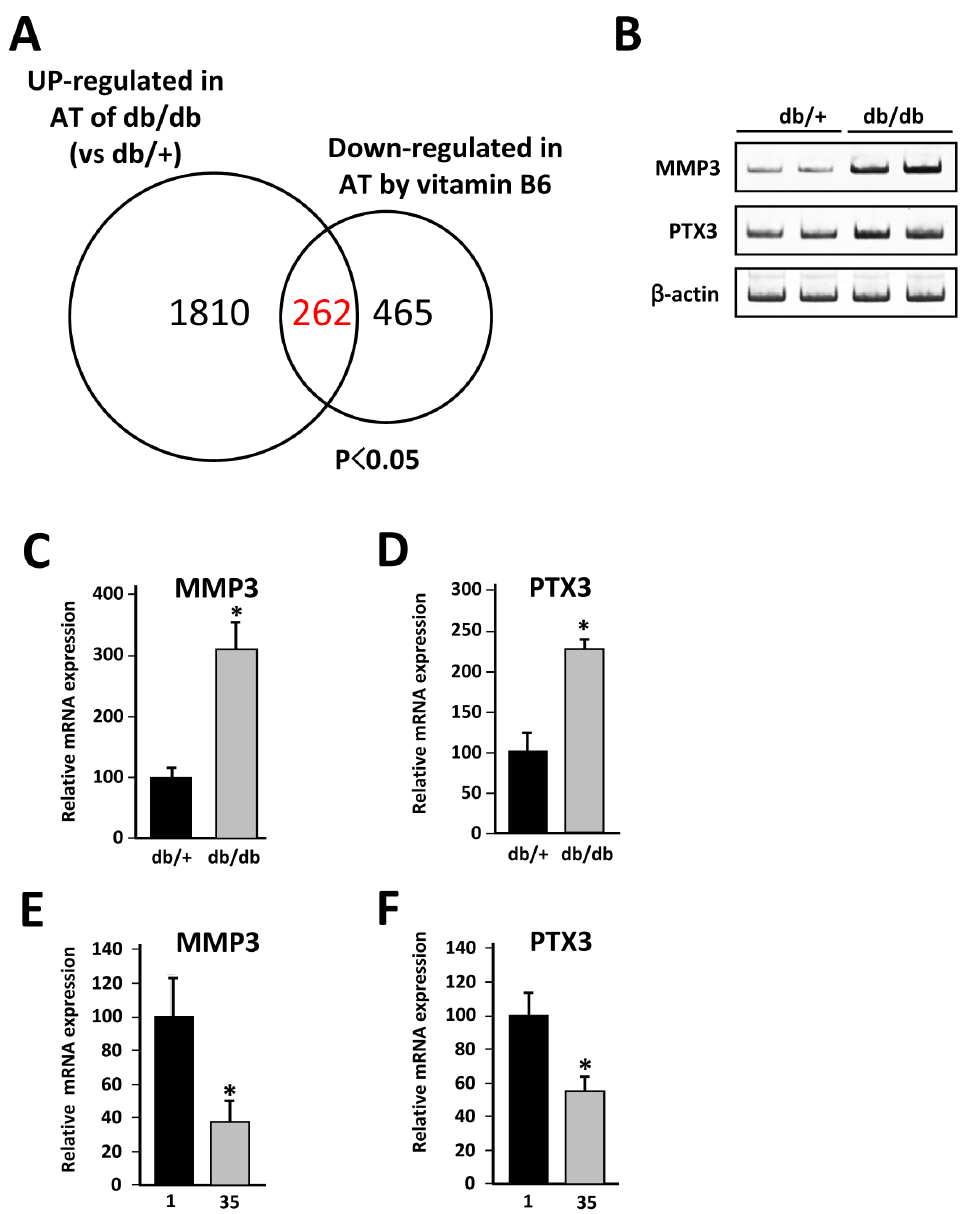
Figure 2. Analysis of two transcriptomes to isolate genes whose expression is upregulated by the interaction with macrophages. A , The Venn diagram shows genes that are upregulated in the db/db white adipose tissue and down-regulated by vitamin B6 supplementation. Of a total 1810 genes up-regulated in db/db adipose tissue, the expression of 262 genes was decreased by dietary vitamin B6 ( p , 0.05). B , Semiquantitative RT-PCR was performed to determine mRNA levels of MMP3 and PTX3 . The level of b -actin ( b -actin ) transcript was used as a control. C , D , Total RNA from individual mice (n=4) in two groups was subjected to quantitative PCR to examine mRNA expression. All values are normalized to b -actin levels. The data (mean 6 S.E.) are representative of two independent experiments. * P , 0.05 compared with those of db/ + mice. E , F , Total RNA from individual mice (n=12) in two groups was subjected to quantitative PCR to examine mRNA expression level. All values are normalized to b - actin levels. The data (mean 6 S.E.) are representative of two independent experiments. * P , 0.05 compared with those of 1 mg/kg PN ( 1